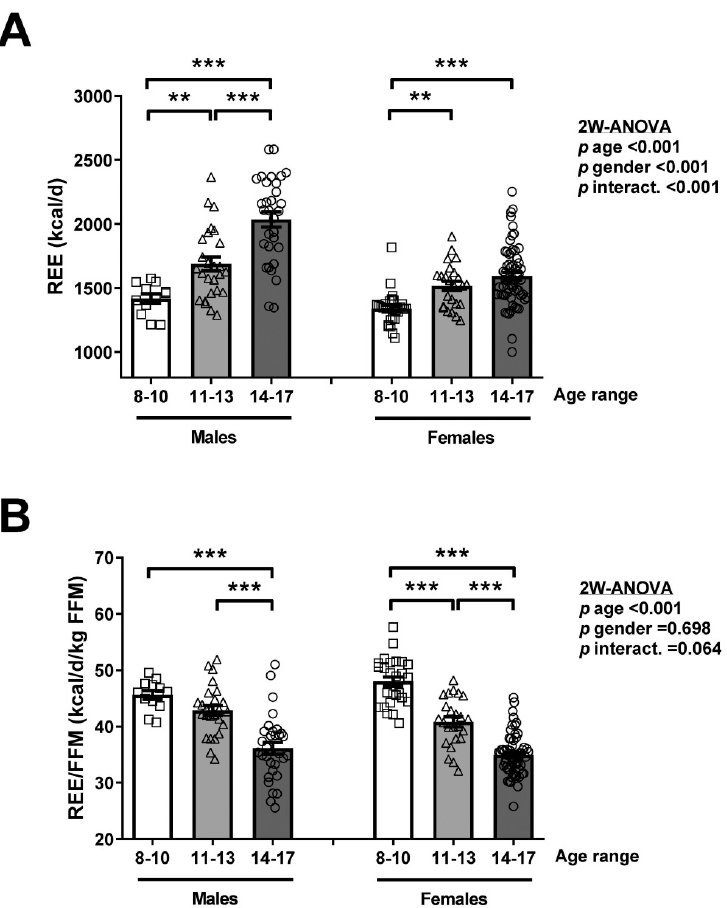
Figure 3. Comparison of absolute REE ( A ) and normalized by FFM ( B ) in the whole sample of children and adolescents ( n = 181) segregated by gender and age groups (8–10, 11–13 and 14–17 years). Values are means ± SEM. Differences between groups were analyzed by two-way ANOVA (age x gender). Differences between age groups within each gender were analyzed by ANOVA followed by LSD tests. ** p < 0.01 and *** p < 0.001 between groups. REE, resting energy expenditure; FFM, fat-free mass.